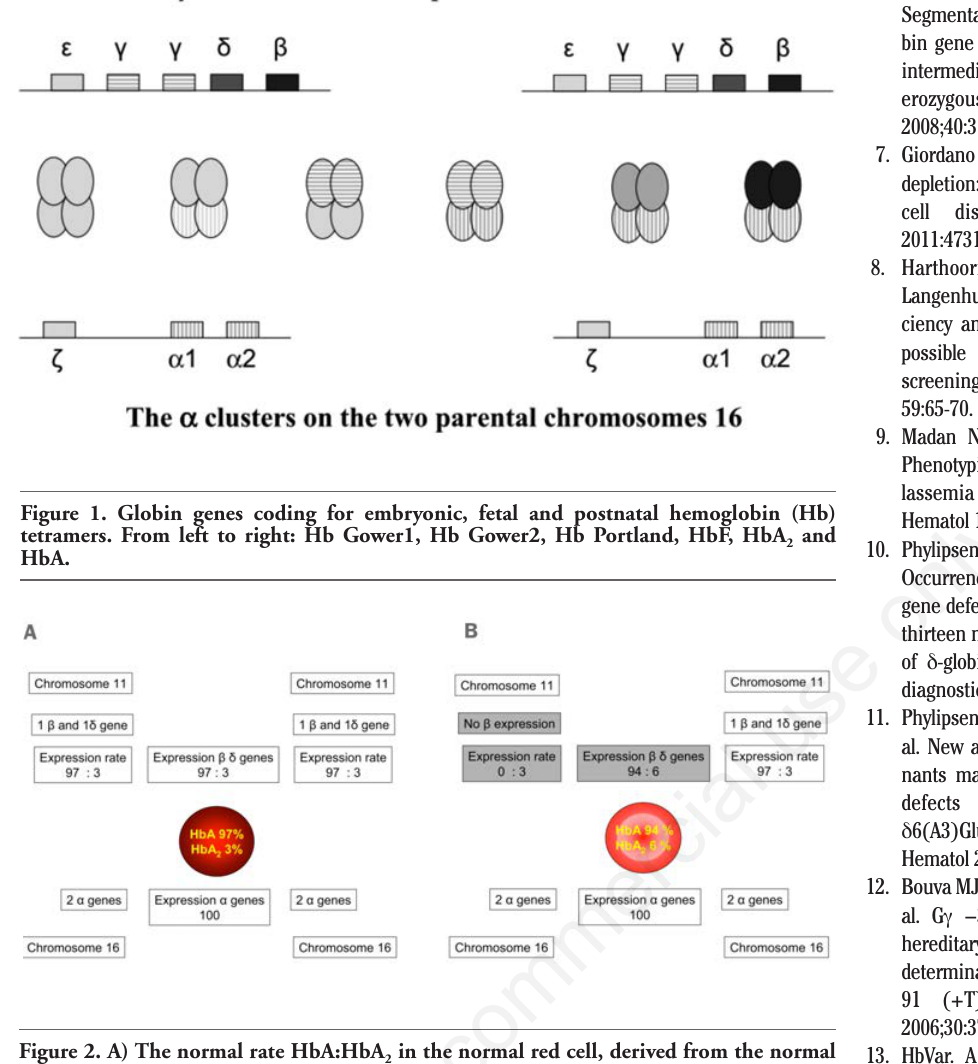
Figure 2. A) The normal rate HbA:HbA in the normal red cell, derived from the normal 2 expression of the b and d genes from both chromosomes 11. B) Elevated HbA value in 2 the b thalassemic red cell, derived from the expression of a single b gene ( b thalassemia minor) from only one chromosome 11 and 2 d genes from both chromosomes